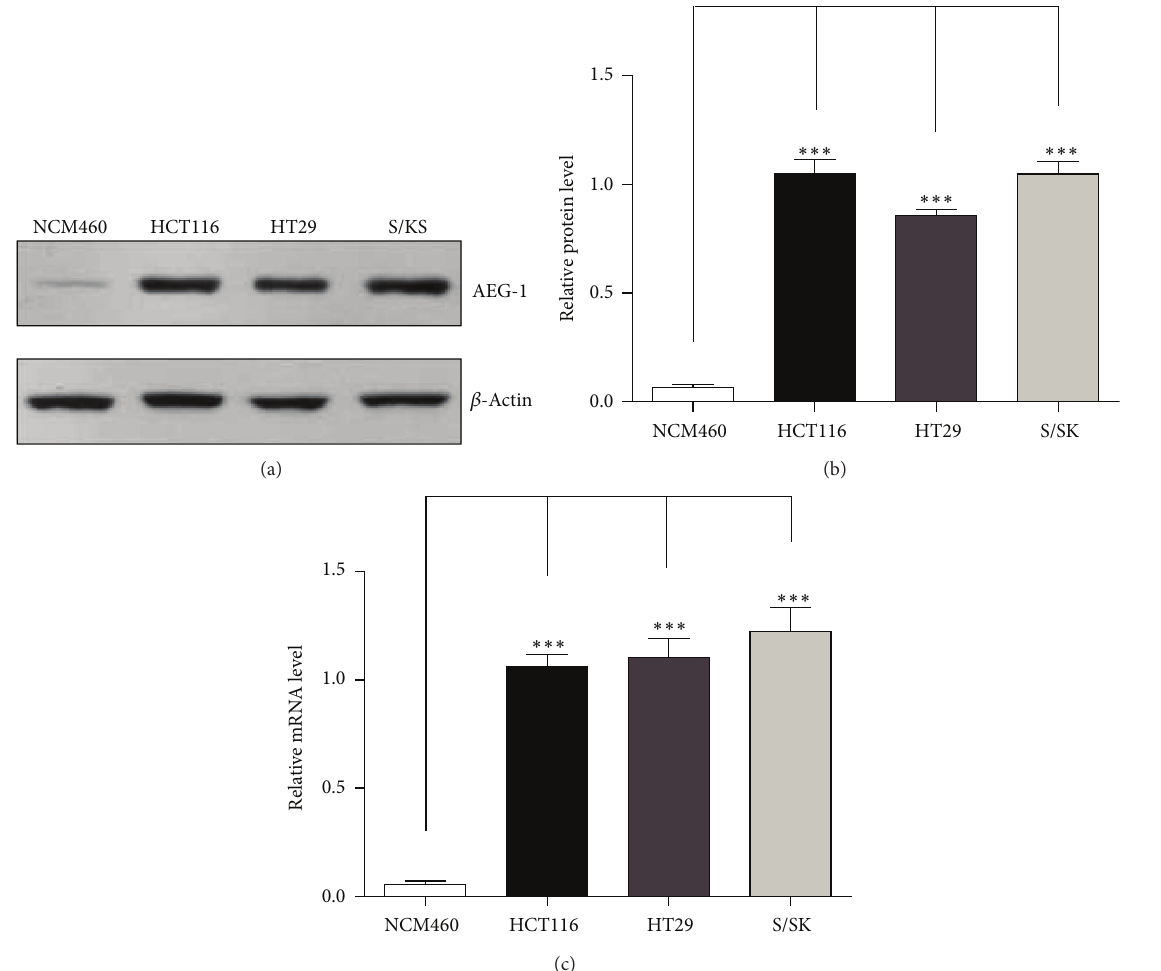
Figure 1: AEG-1 was highly expressed in human colon carcinoma cells. ((a)-(b)) Western blots and histograms showing that AEG-1 protein levels were dramatically increased in HCT116, HT29, and S/KS cells than that in NCM460 cells. Results were averages of four independent experiments. Data represent mean ± SEM. ∗∗∗ 𝑃 < 0.001 . (c) Real-time PCR results showing that AEG-1 mRNA levels were upregulated in HCT116, HT29, and S/KS cells than that in NCM460 cells. Results were averages of four independent experiments. Data represent mean ± SEM. ∗∗∗ 𝑃 < 0.001